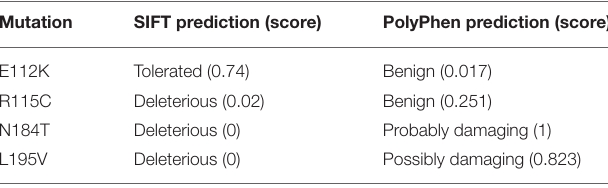
TABLE 1 | Results of pathogenicity prediction programs for MIT domain sequence changes identified in HSP